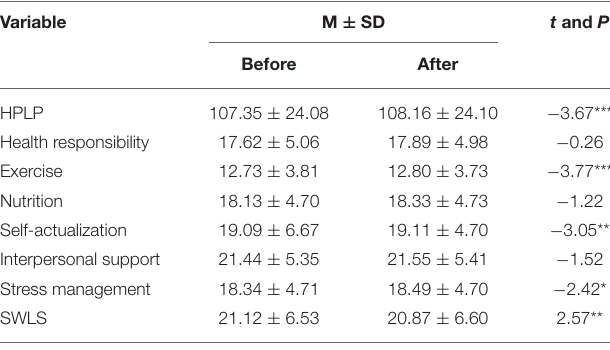
TABLE 2 | Comparison of Health-Promoting Lifestyle Profile (HPLP) and Satisfaction with Life Scale (SWLS) before and after the COVID-19 pandemic ( N =